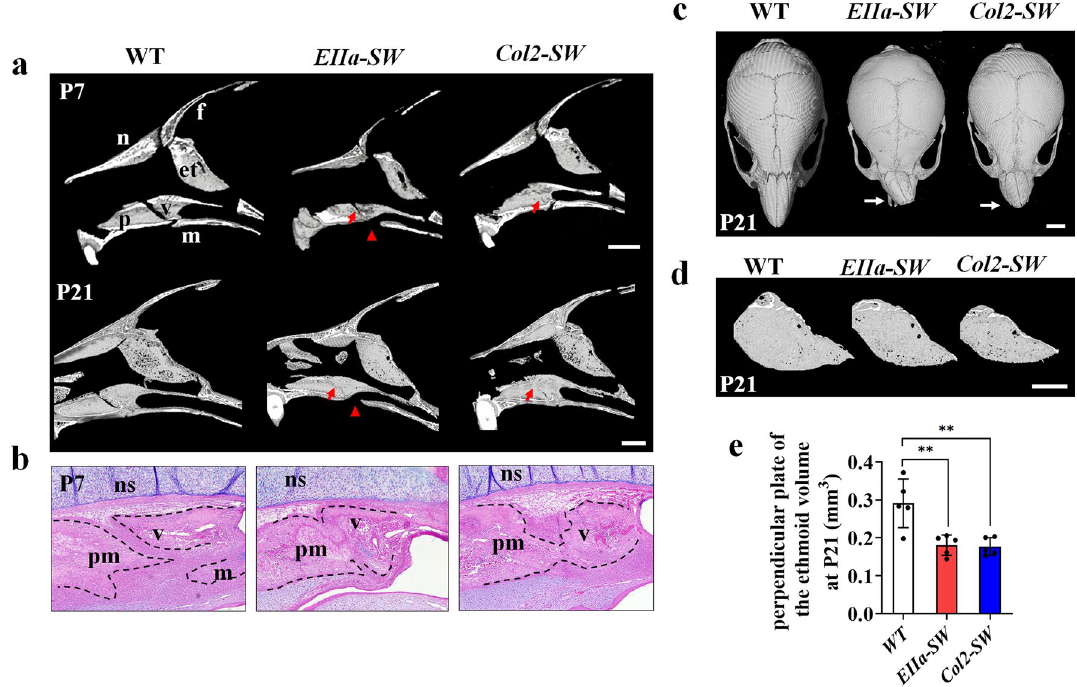
Figure 2. Facial deformities in Col2-SW mice are mainly developed in nasal septum-associated structure. ( a ) Micro-CT images of mouse skulls in the midsagittal plane at P7 and P21. The red arrows indicate the closure between the premaxilla and the vomer. The red arrowheads indicate palate perforation. Scale bar: 1 mm. ( b ) Hematoxylin, eosin, and Alcian blue staining of skulls of P7 mice in the midsagittal plane. The dotted line indicates the edge of each bone. Abbreviations: n, nasal bone; f, frontal bone; pm, premaxilla bone; v, vomer; et, ethmoid bone; m, maxilla; ns, nasal septum. Scale bar: 1 mm. ( c ) Superior view of the skull. The white arrows on the mutant mice indicate the deviation of the nasal bone. Scale bar: 2 mm. ( d ) Micro-CT images of the perpendicular plate of the ethmoid bone at P21. ( e ) Measurement of perpendicular plate of ethmoid bone volume. Scale bar: 1 mm. Values are presented as means ± standard deviations. * p ≤ 0.0332, ** p ≤ 0.0021 ( n =